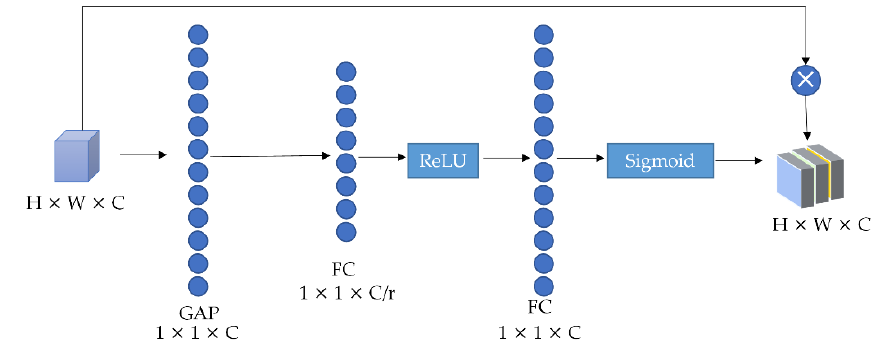
Figure 3. Schematic diagram of channel attention.